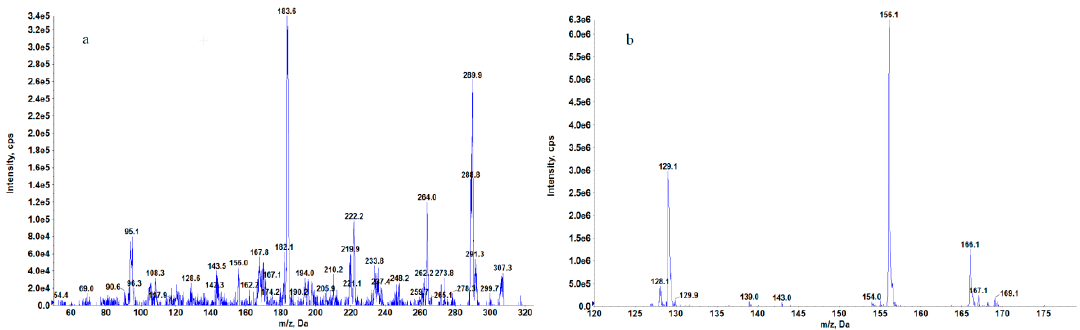
Figure 4. ( a ) MS 2 and ( b ) MS 3 spectra of strychnine in liver matrix.